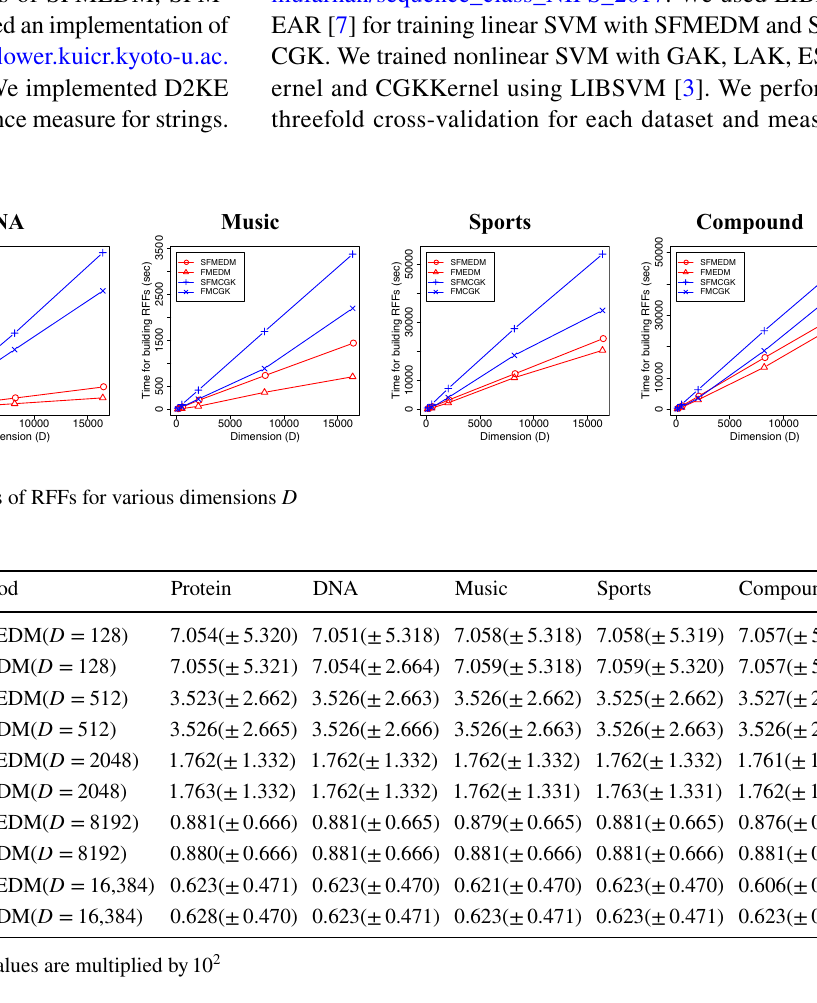
Table 5 Average error by SFMCGK and FMCGK for each dataset